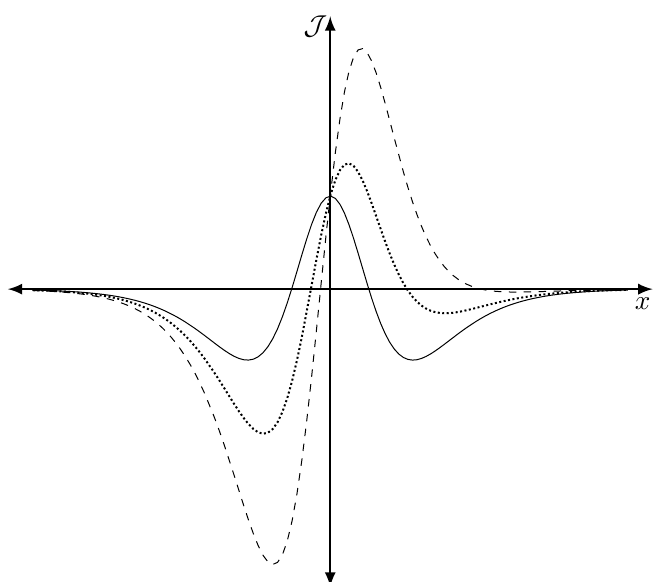
Figure 1 . The form of J in (4.63) is plotted for generic (cid:12)xed values of c P , c J , a , v and for di(cid:11)erent values of (cid:17) 1 . Note that when the integration constant (cid:17) 1 vanishes, J becomes an even function of x (solid